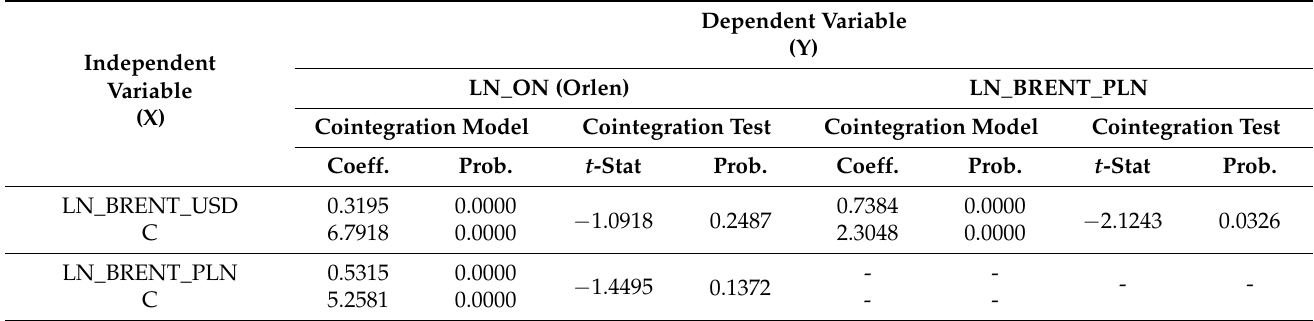
Table 6. Cointegrations models and tests (B).